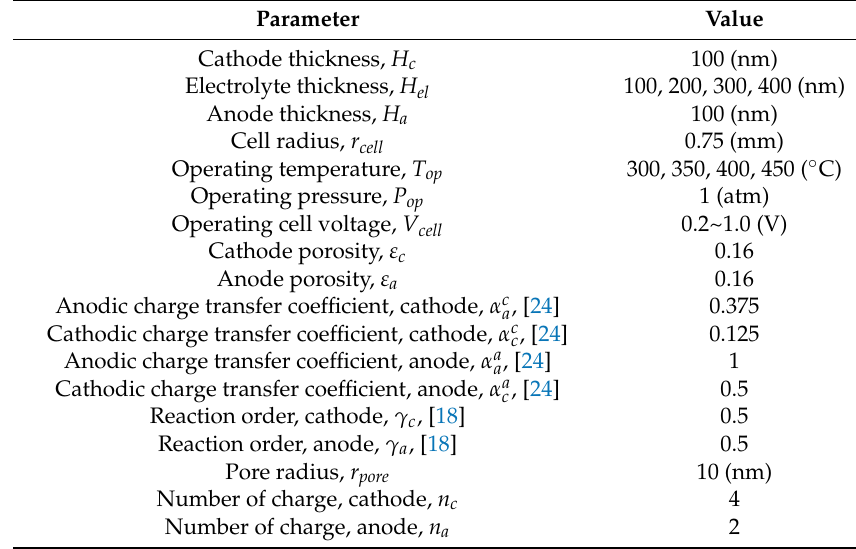
Table 2. Geometrical and electrochemical